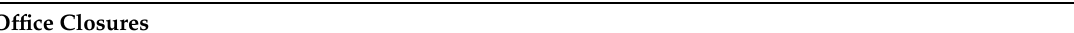
Table 2. Dentistry during COVID-19: Experiences during the first